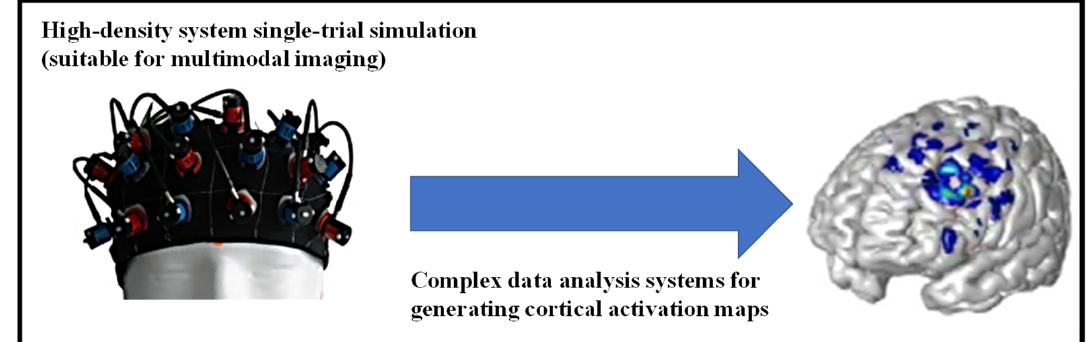
Figure 4. Multichannel fNIRS instrument.